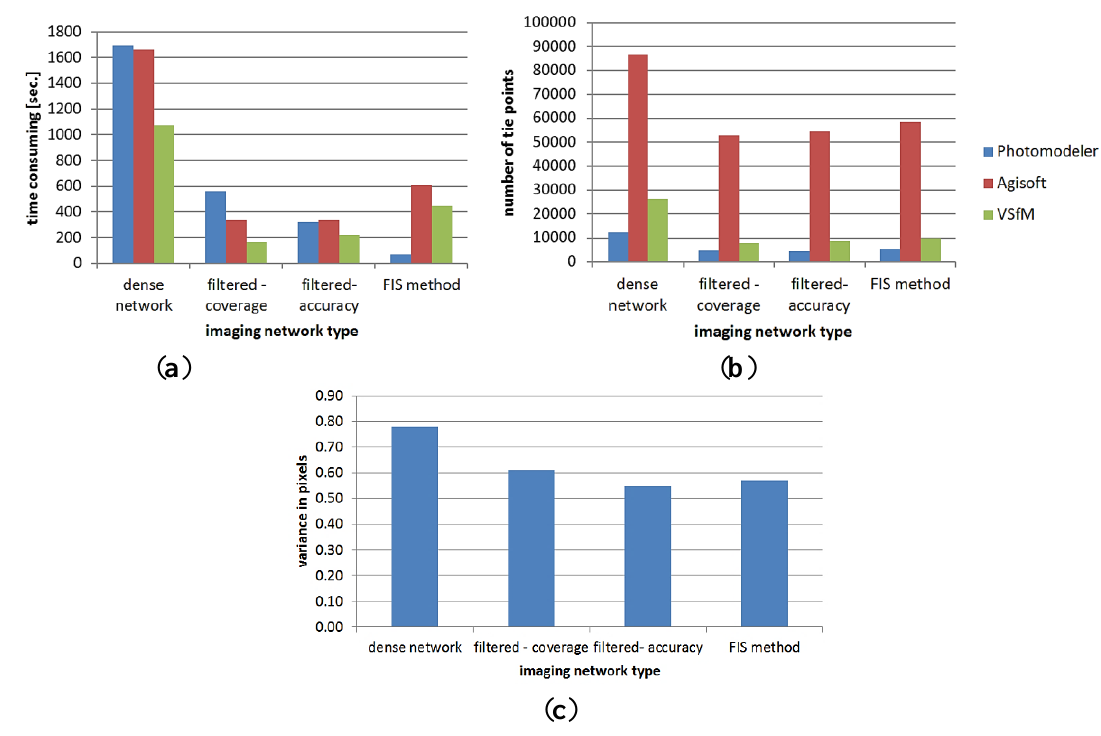
Figure 15. Comparison of the image orientation with different software. ( a ) Consumed time; ( b ) Number of tie points; ( c ) Reference variance after image orientation.